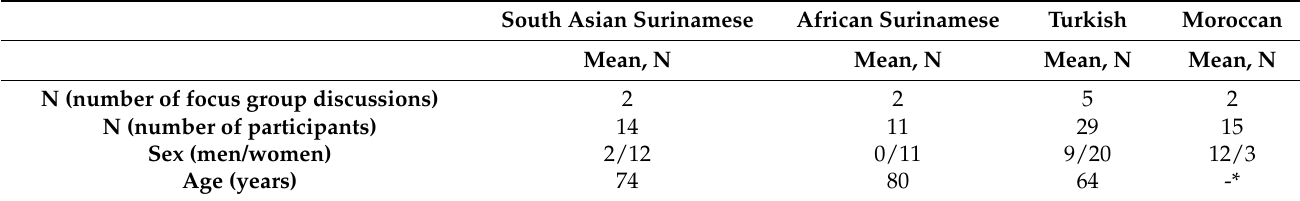
Table 2. Subject characteristics of the focus group